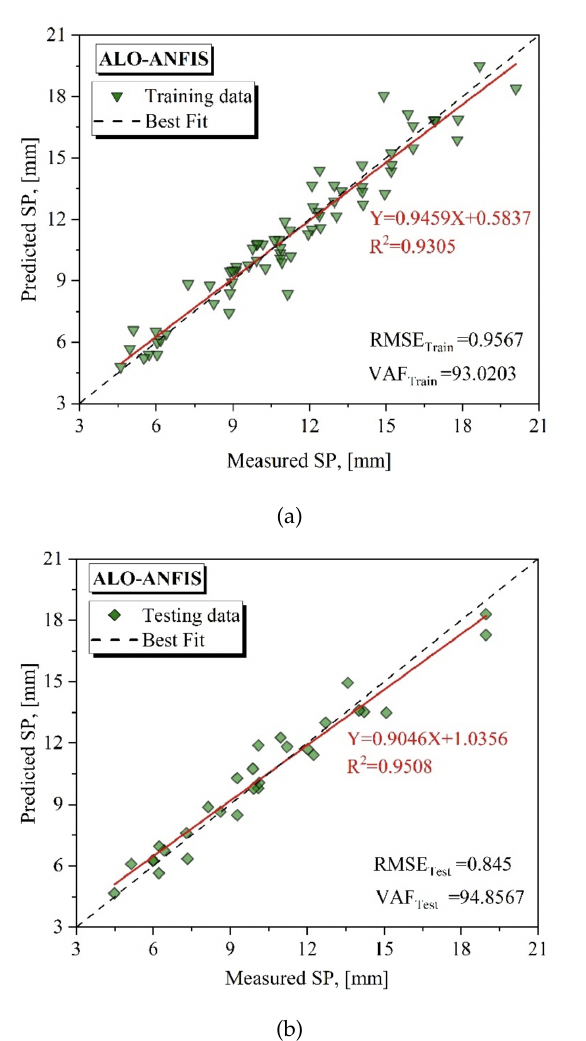
Fig. 11. Comparison between measured and predicted the pile settlement using GOA-ANFIS: a) Train; b)